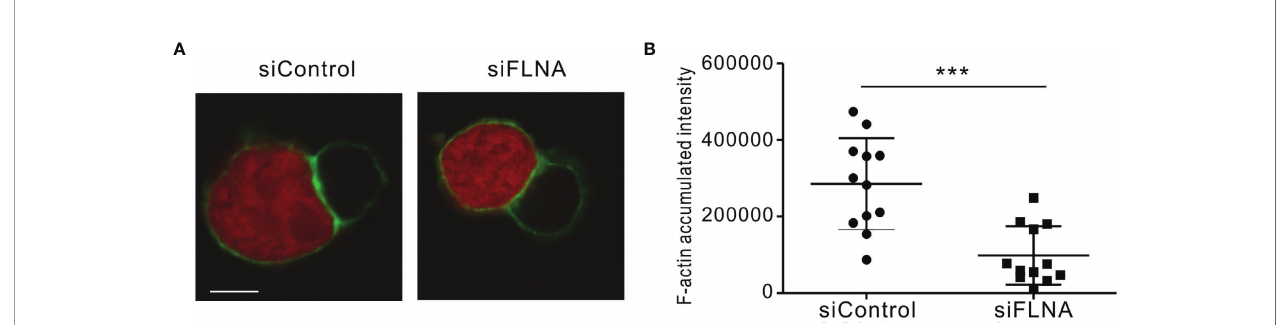
FIGURE 5 | F-actin density reduction by an FLNa de fi ciency at the NK IS. (A) NKL cells nucleofected with control or FLNa-speci fi c siRNAs were incubated with Cell tracker orange CMTMR-loaded 721.221 cells (red) for 15 min, fi xed, permeabilized, and stained for F-actin (green). F-actin accumulation at the IS between NKL and 721.221 cells was analyzed by confocal imaging. The image is representative of 12 conjugates analyzed. (B) F-actin accumulation at the NK IS was estimated using a reconstruction of serial confocal images acquired via the z-axis and a single compressed image of the NKL and 721.221 cells conjugate shown in (A) . A summary graph is presented. The horizontal line represents the mean, and the vertical bar indicates the SD; *** P < 0.001. Scale bar, 5 m m. Results are representative of three independent